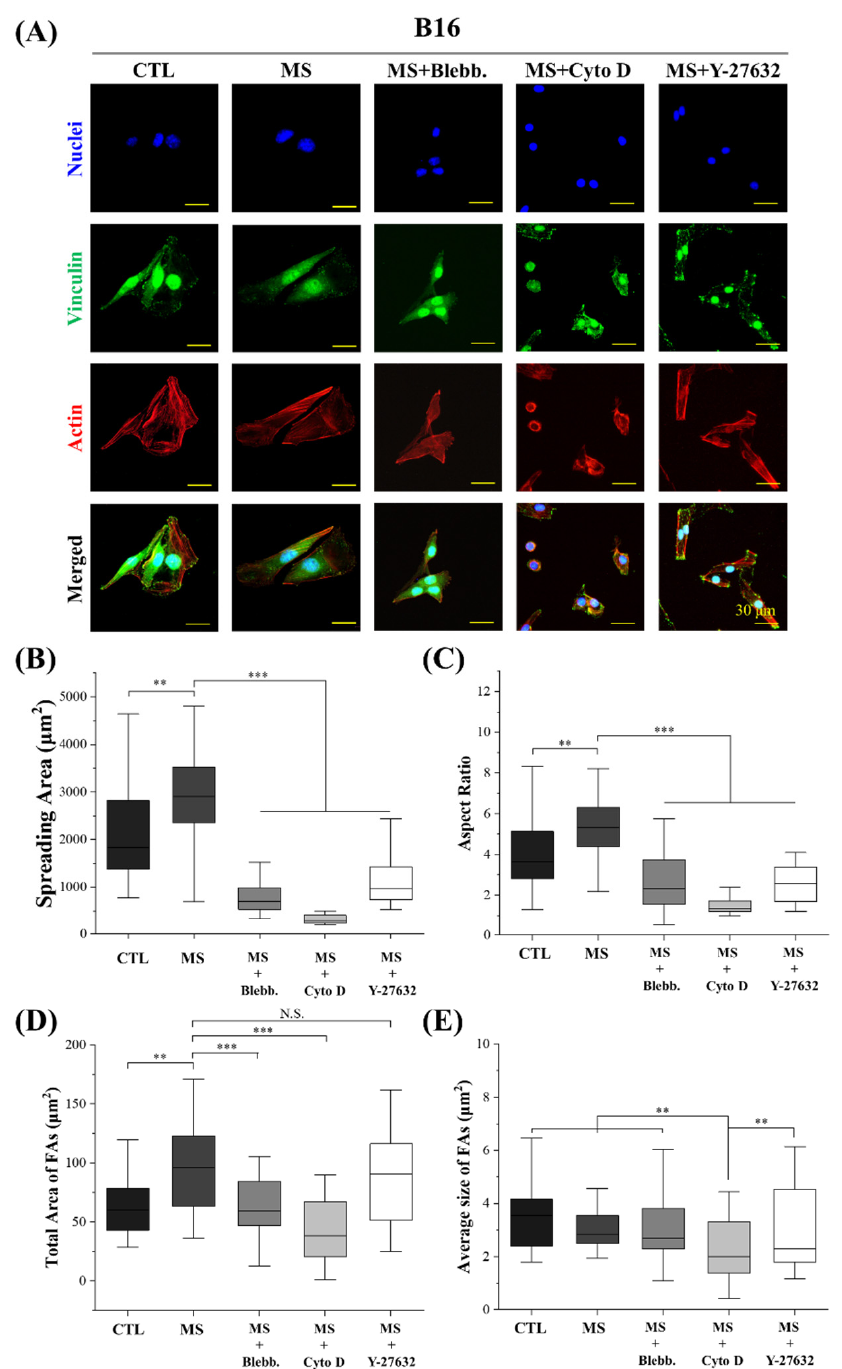
Figure 5. Influence of cyclic straining and inhibitors on the morphogenesis of B16 cells. ( A ) Repre- sentative fluorescent images of actin, vinculin, and nuclei-stained B16 cells. ( B ) Spreading area of B16 cells (n > 30). ( C ) Aspect ratio of B16 cells ( n > 30). ( D ) Total size of focal adhesions in B16 cells. ( n > 30). ( E ) Average size of focal adhesions in B16 cells ( n > 30). ** p < 0.01, *** p < 0.001, N.S.: Not